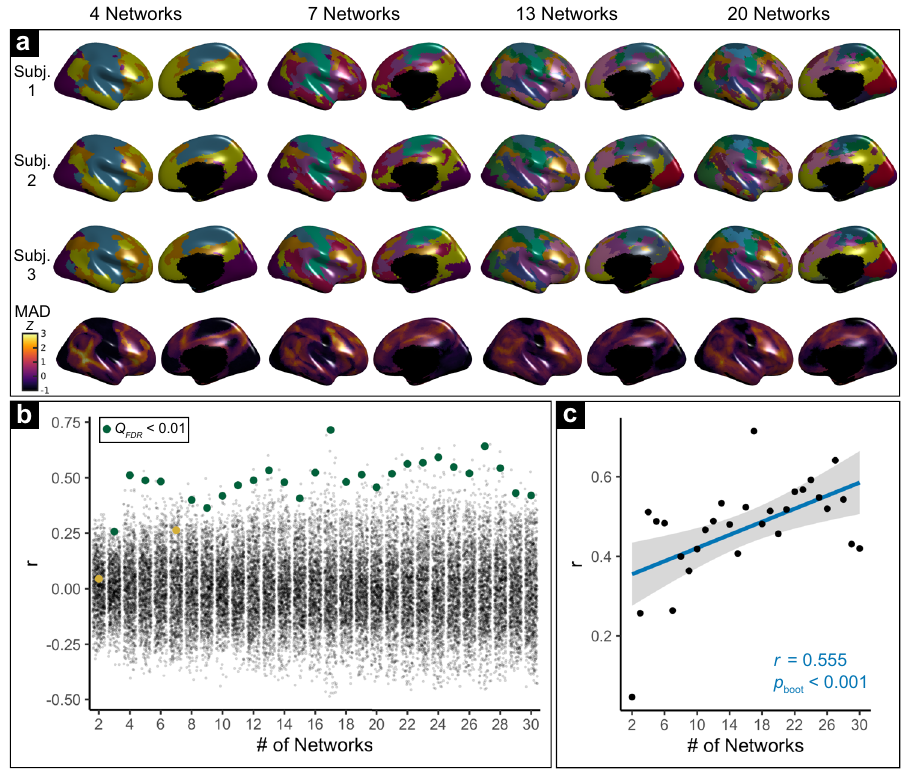
Fig. 2 Variability in personalized networks across scales. a Variability in personalized networks is greatest in association cortex across scales. Exemplar personalized networks at scales 4, 7, 13, and 20 are shown for three participants. Prominent individual differences in functional topography are present at all scales, as quanti fi ed by median absolute deviation (MAD) of functional network loadings across participants (bottom row, z-scored within each scale). b Variability of functional topography aligns with functional hierarchy. Spin-tests of the correlation between topographic variability and the principal functional connectivity gradient 17 at each scale reveal that variability is signi fi cantly correlated with a sensorimotor-to-association hierarchy at most scales (green dots = signi fi cant correlations; yellow dots = non-signi fi cant correlations; black dots = spin-test null correlations, FDR false discovery rate). c Greater alignment between a sensorimotor-to-association hierarchy and topographic variability is present at fi ner scales. Scatterplot depicts second- order correlation of variability (MAD) and the principal gradient (from b ) across scales. The statistical test is two-sided. Error bands depict the 95% con fi dence